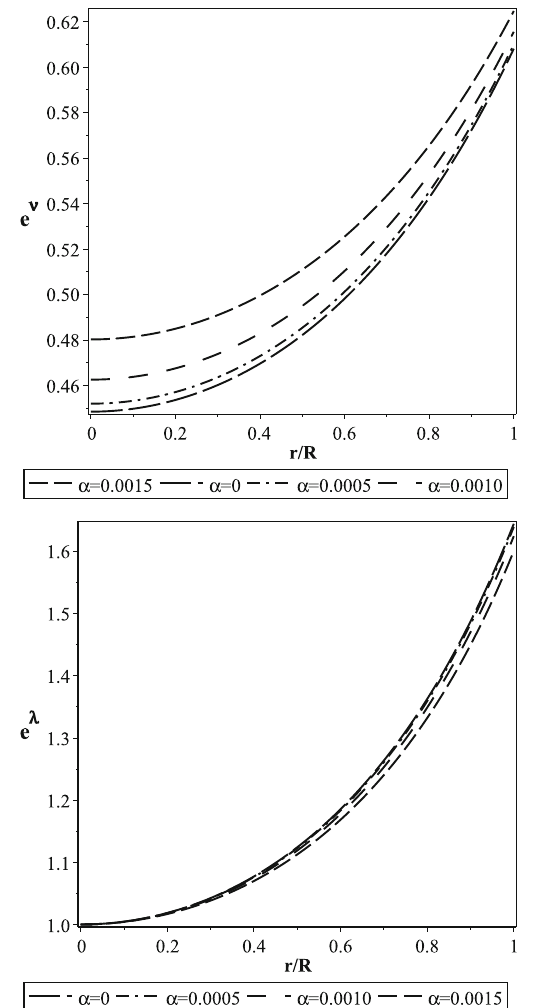
Fig. 1 Variation of (i) e ν( r ) (upper panel) and (ii) e λ( r ) (lower panel) as a function of the radial coordinate r / R for the strange star LMC X − 4. Here B = 83 MeV / fm 3